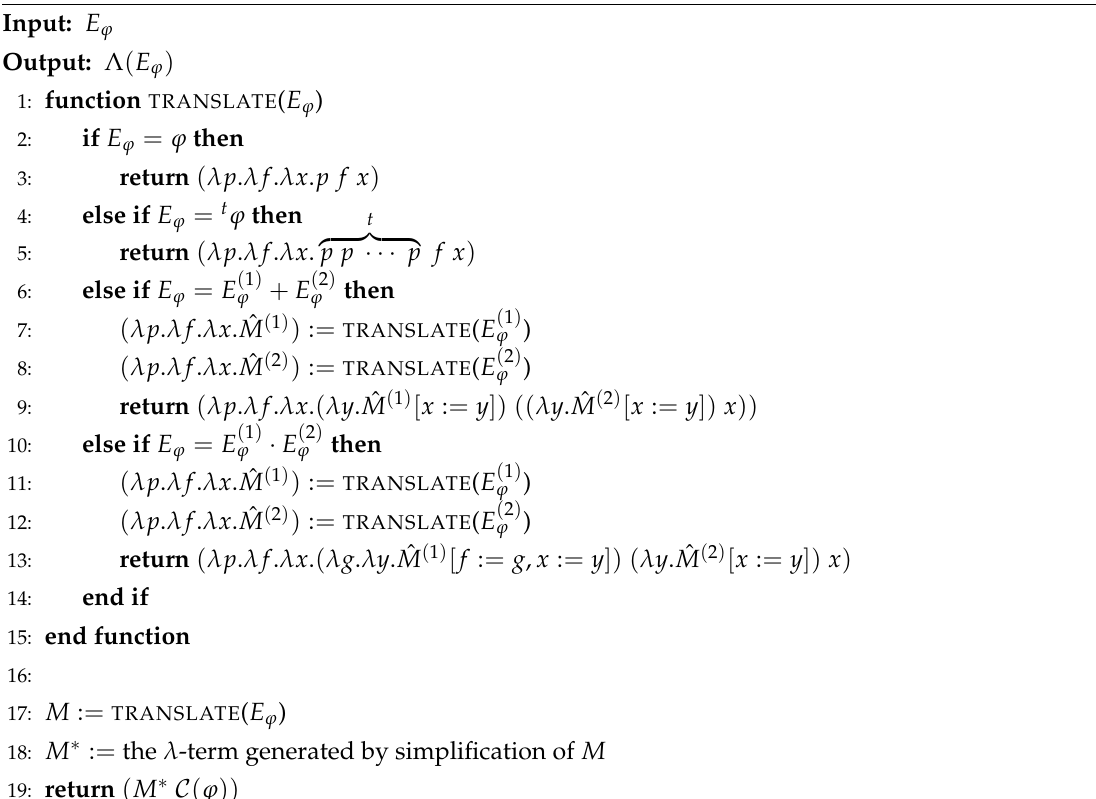
Algorithm 1 Translation from E ϕ to its